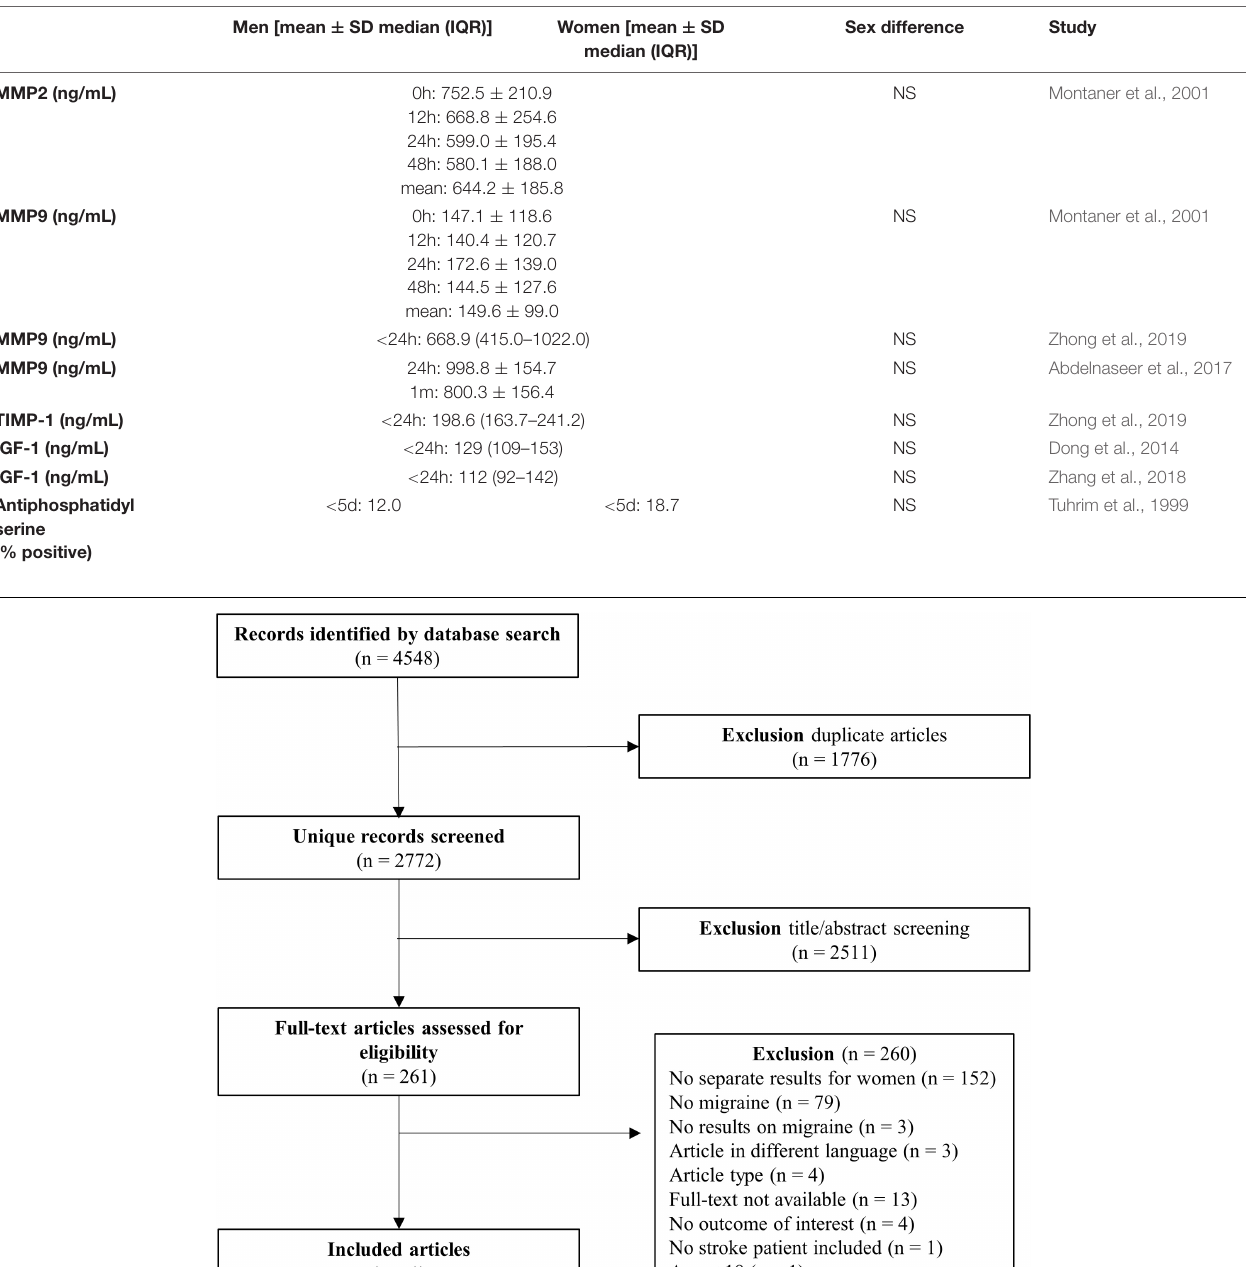
FIGURE 2 | PRISMA flow chart study selection ischemic stroke and migraine in women.